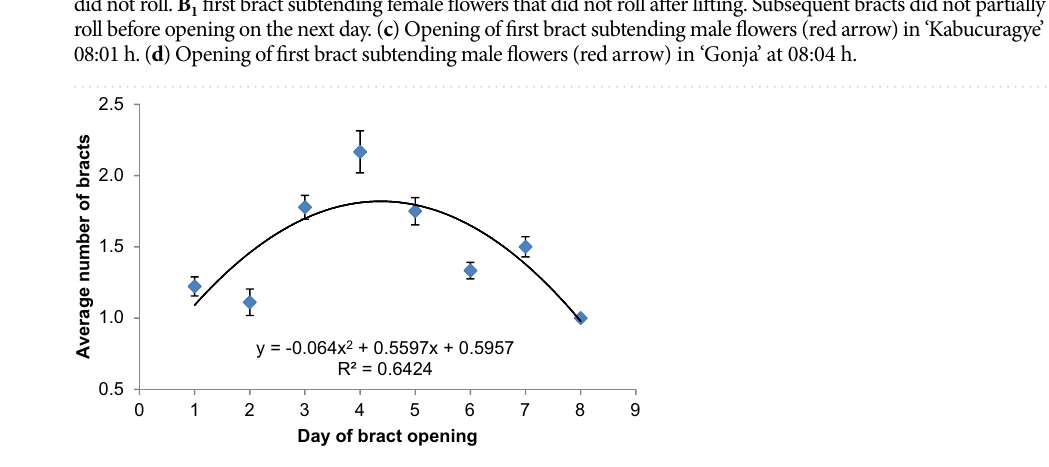
Figure 2. Average number of bracts subtending female flowering opening per day during opening period of selected inflorescences of banana genotypes; error bars denote mean ± 10% standard